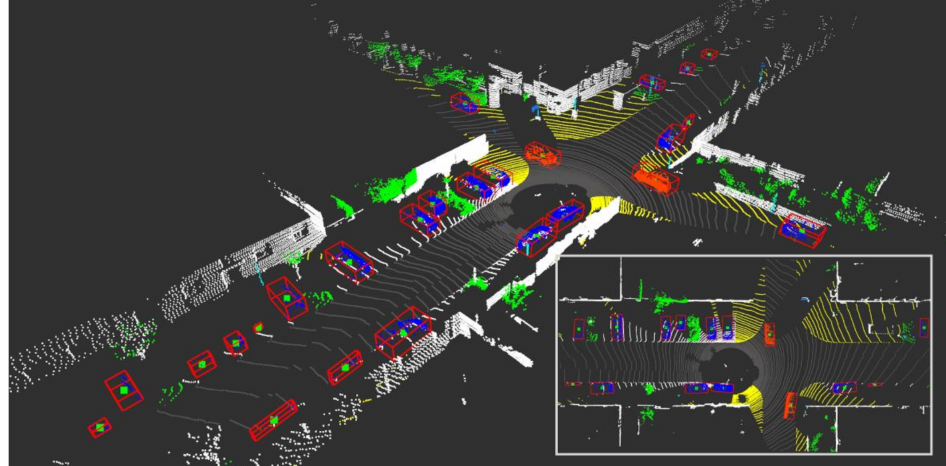
Figure 2. Vehicle pose estimation result based on the 3D point cloud. The blue points represent static obstacle vehicles, the orange points represent dynamic obstacle vehicles, and the red bounding box represents the pose estimation result. Our approach can accurately estimate the tiny angular deviation of obstacle vehicles. As shown from the bird’s eye view, our approach could effectively estimate the direction of these two dynamic obstacle vehicles even if their directions only changed